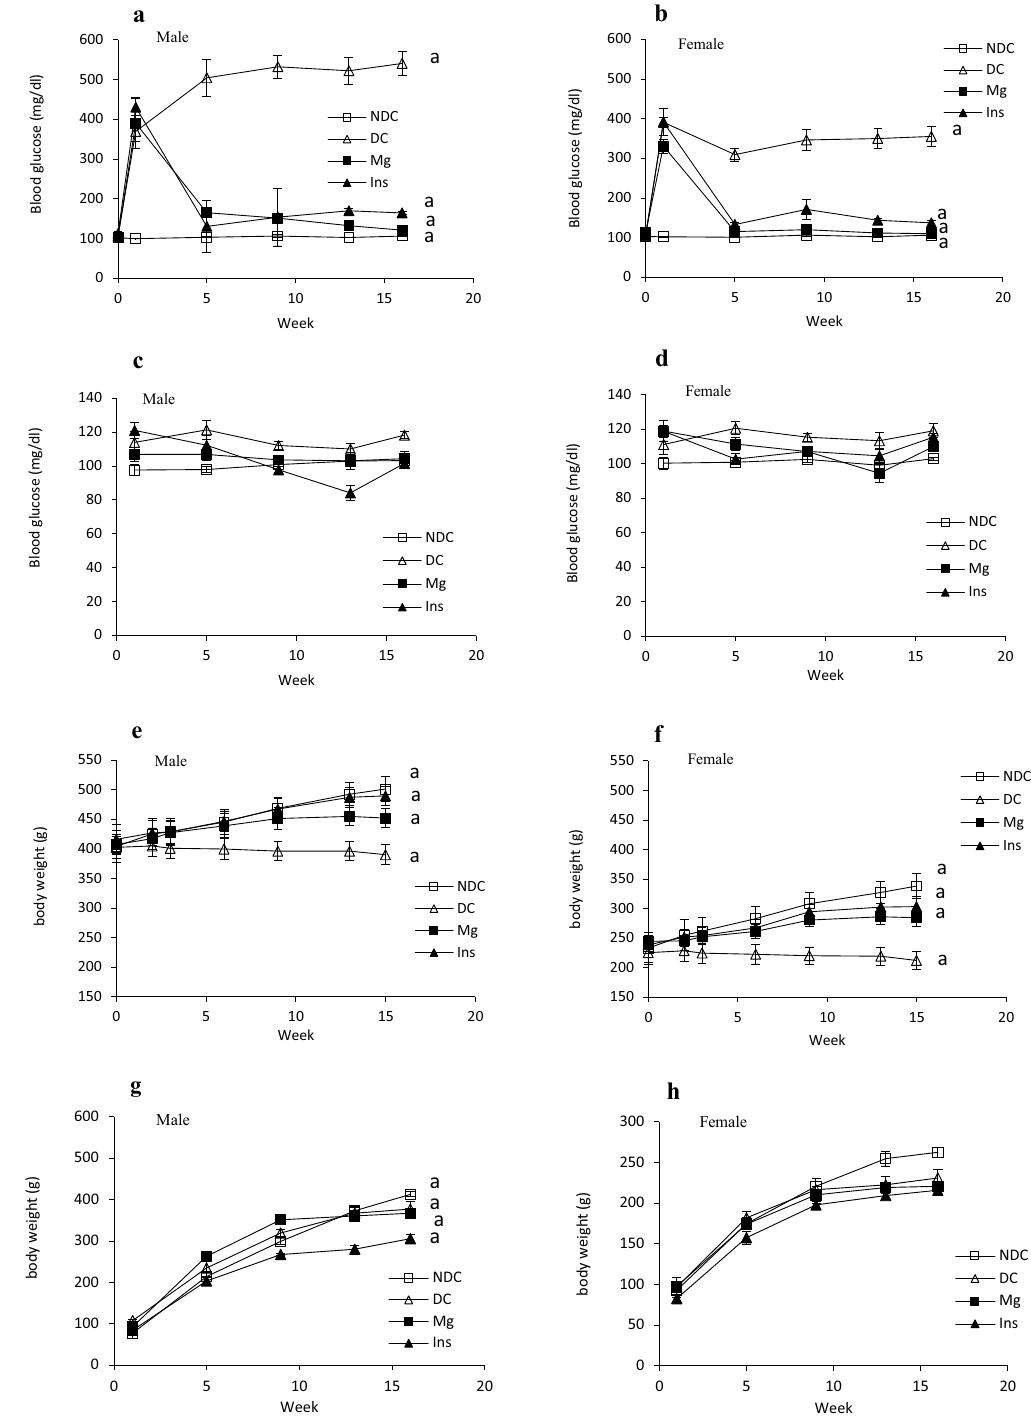
Figure 3. Comparison of fed blood glucose in male and female parents and their male and female offspring ( a , b , c and d respectively) and body weight in male and female parents and their male and female offspring ( e , f , g and h respectively) in non-diabetic control group (NDC) was fed with normal diet, diabetic group received high-fat diet and 35 mg/Kg STZ (D), diabetic animals treated with insulin (2.5 U/Kg two time per day) (Ins) and diabetic animals treated with 10 g/l magnesium sulfate via drinking water (Mg). 10 rats in each group and data are expressed as mean ± SEM. ( a ) Significant difference between D male and female groups and other male and female groups ( P <